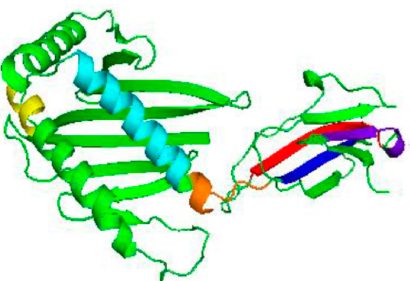
Figure 7. Structure of MIC-A showing the predicted epitopes in different colours. Depicted on the MIC-A protein structure are the predicted potential antigenic peptides in various colours, which are found in the transmembrane topology: the first, second, and third are represented by yellow, cyan and orange, while the fourth, firth, and sixth are shown in blue, red, and purple.